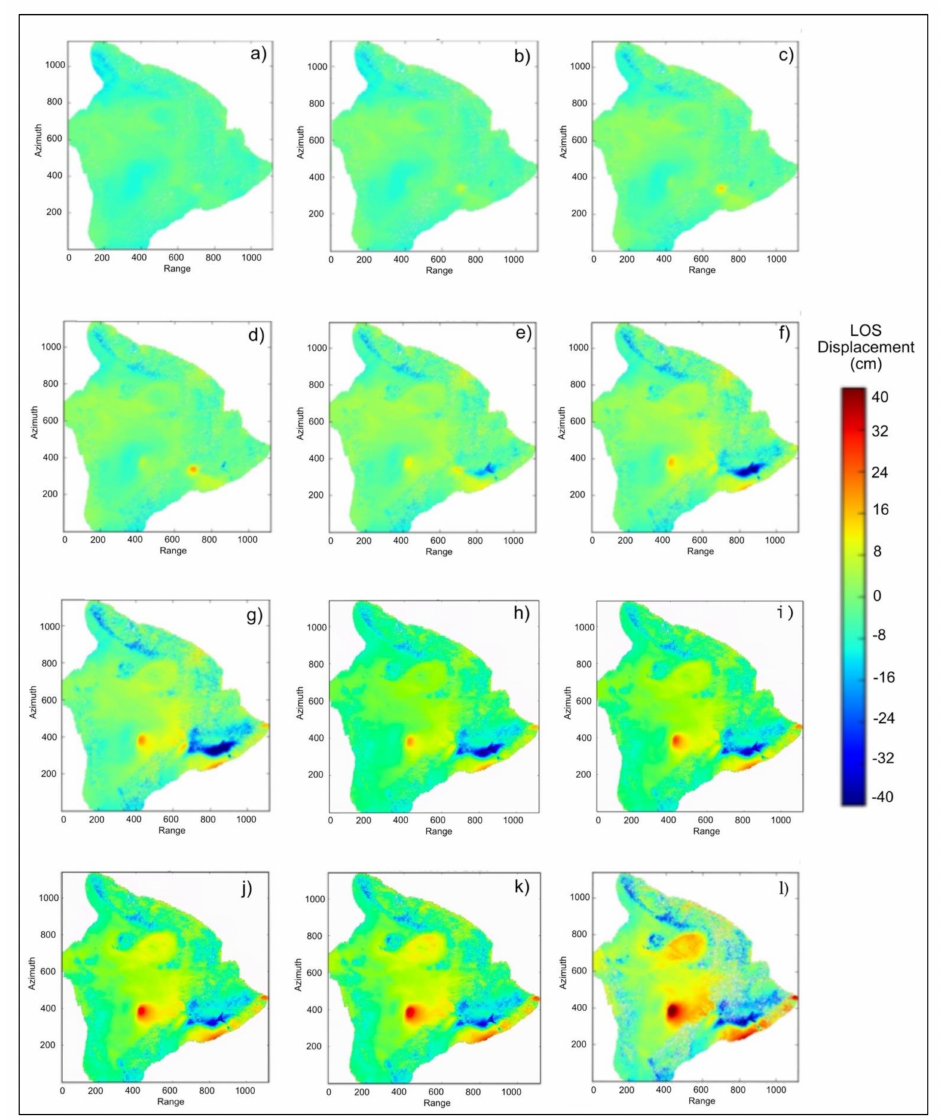
Figure 3. Cumulative LOS displacement DInSAR time series results for Sentinel-1A/B Path 87 Frame 526 data over the Big Island of Hawaii from November 2015 to April 2021. These are twelve of the possible 275 time-steps from the 5.5-year-long time series. Each submap corresponds to the total deformation between ( a ) 11 November 2015 and ( b ) 09 May 2016; ( c ) 05 November 2016;